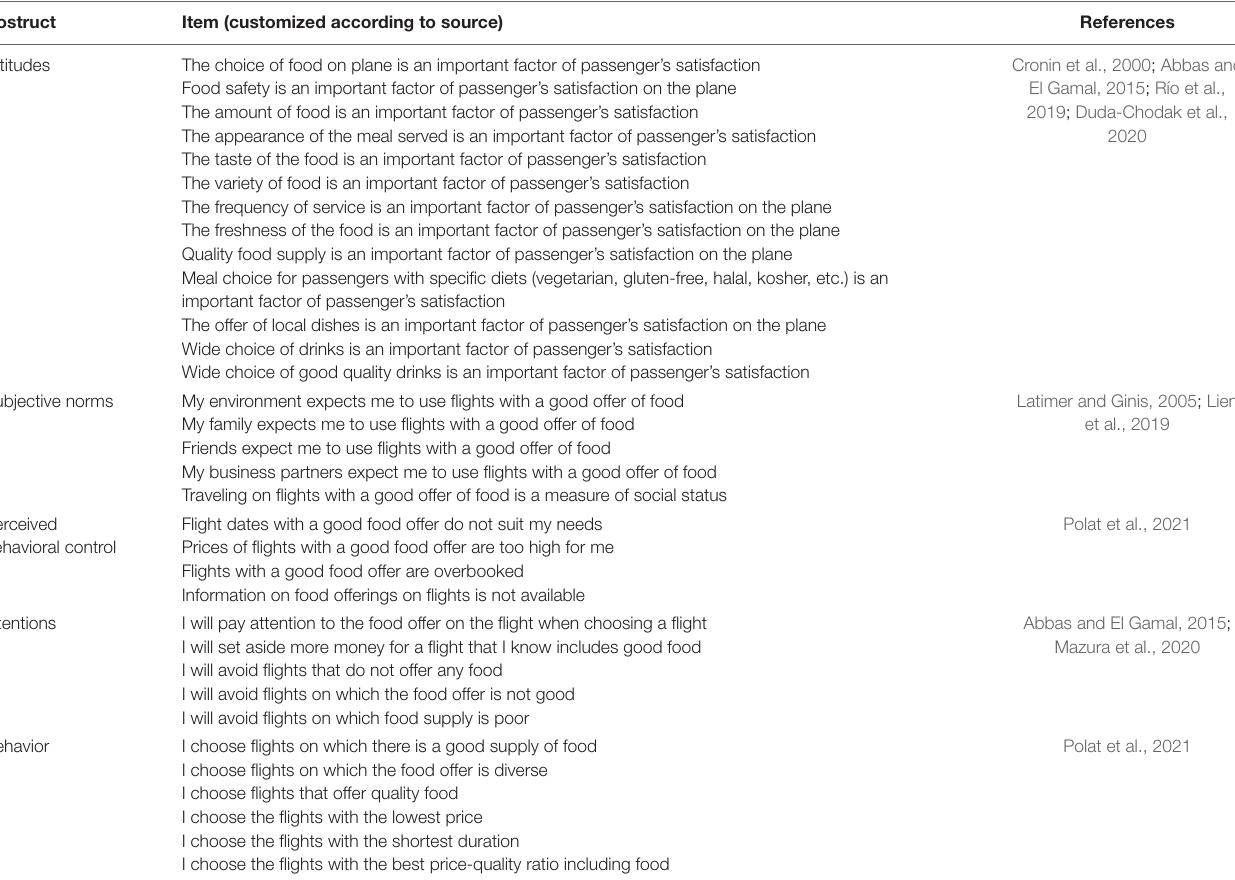
TABLE 1 | Survey questionnaire and